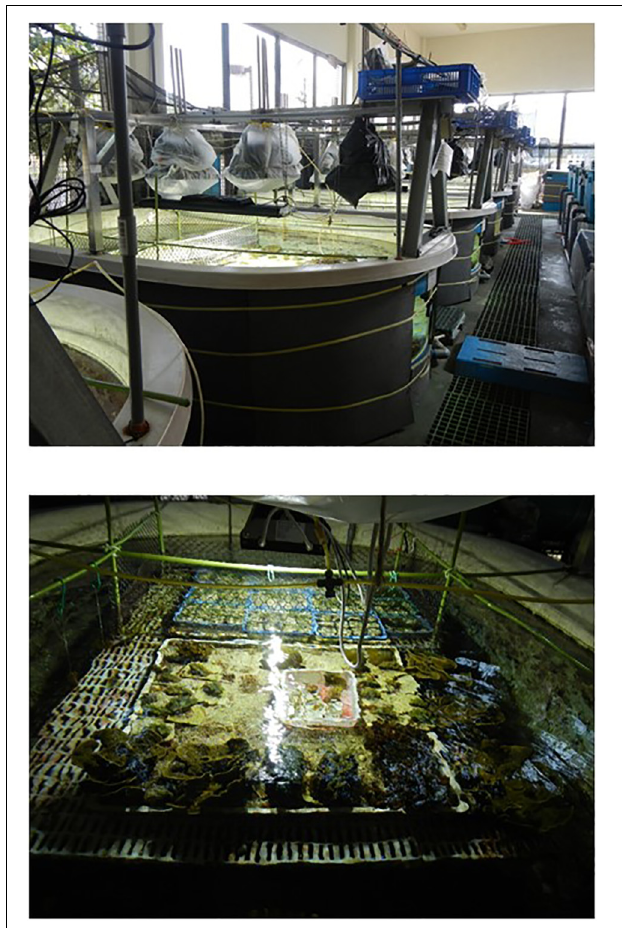
FIGURE 1 | Continuous-flow of coral reef mesocosm facility at the National Museum of Marine Biology and Aquarium, southern Taiwan. Upper panel: outside view; lower panel: inside